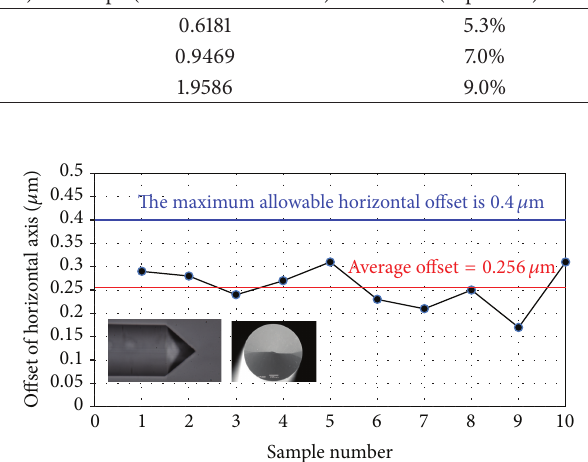
Figure 12: Offset between grinding end-face and center line of fiber core at 45 ∘ tilt